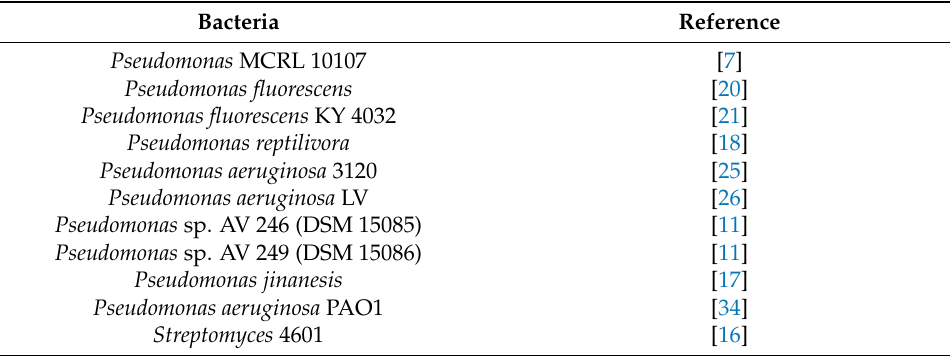
Table 1. List of Fluopsin C-producing bacteria.